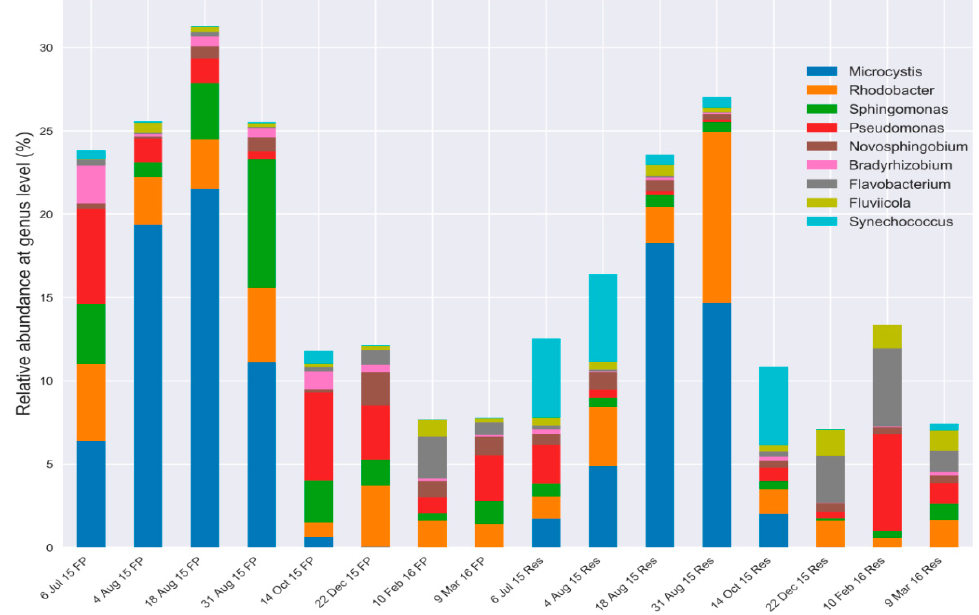
Figure 3. Relative abundance of predominant bacterial genera in FP-03 (FP) and the Res (Res) based on 16S rRNA gene amplicon sequencing analyses .